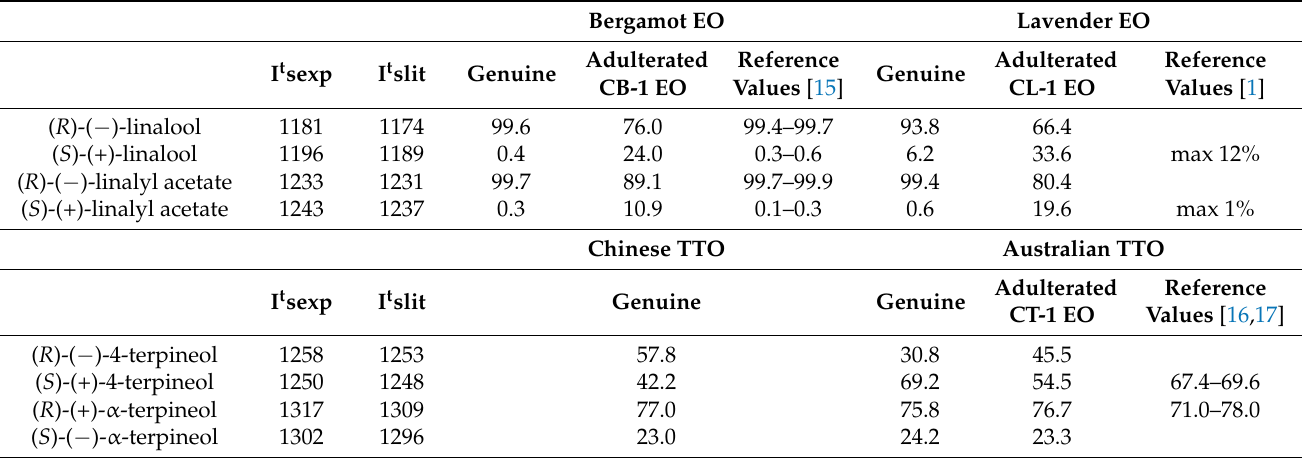
Table 2. Percent enantiomeric composition (EC%) of some representative markers in genuine and adulterated bergamot (commercial bergamot EO: CB-1 EO), lavender (commercial lavender EO: CL-1 EO) and TTO (commercial tee tree oil: CT-1 EO) EO compared to the literature data ( n =